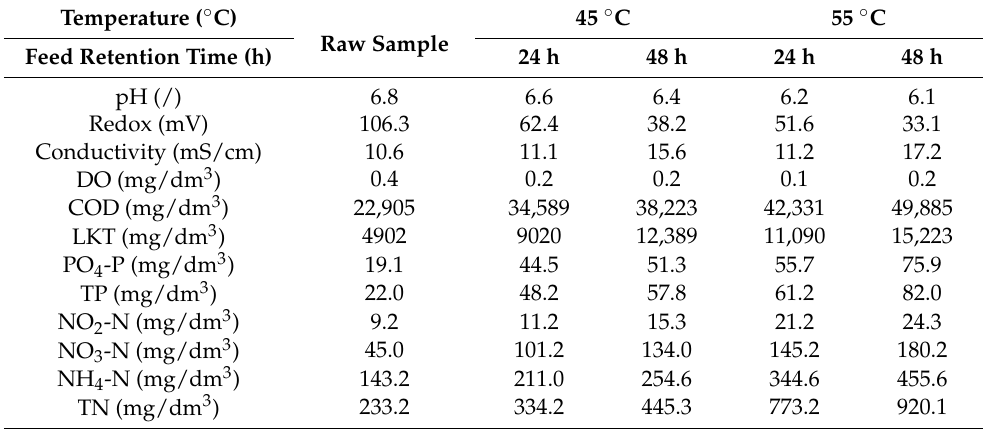
Table 3. Physical and chemical characteristics of the dissolved phase of the initial feed and after being subjected to the low-temperature disintegration